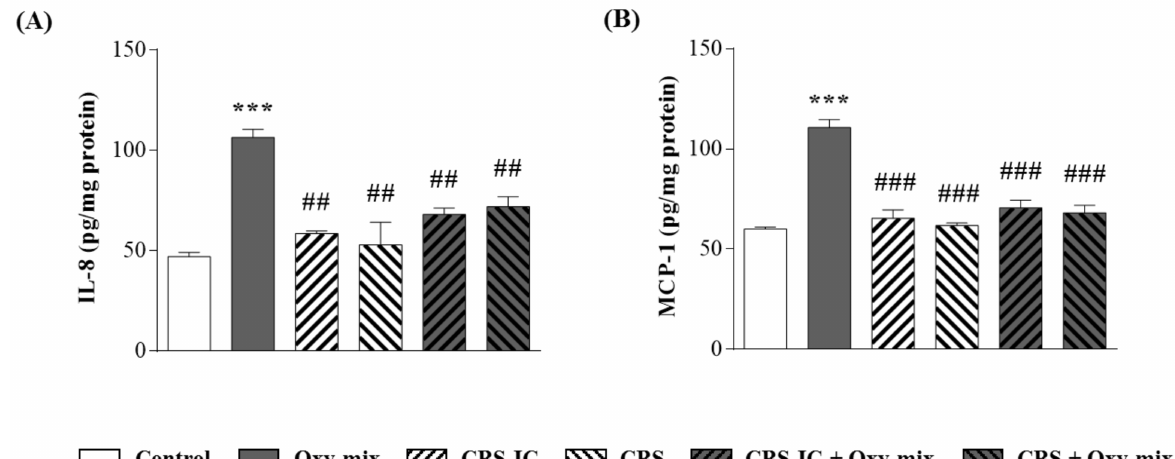
Figure 1. Oxy-mix-mediated inflammation was prevented by CBS extracts. IL-8 and MCP-1 levels (( A ) and ( B ), respectively) were measured by ELISA in the cell medium of differentiated CaCo-2 cells pretreated or not with 4% CBS-enriched ice cream (CBS-IC) or CBS alone for 1 h and incubated with 60 µ M oxysterol mixture (Oxy-mix) for 24 h. Both pretreatments were able to fully prevent the Oxy-mix-dependent cytokine protein level increase in the cell medium. Values are shown as pg chemokines normalized for cell incubation medium mg proteins (pg/mg protein). Values are referred as means of three independent experiments ( n = 3) evaluated in triplicate ± SD. Significantly different vs. controls: *** p < 0.001; significantly different vs. Oxy-mix: ## p < 0.01, ### p <